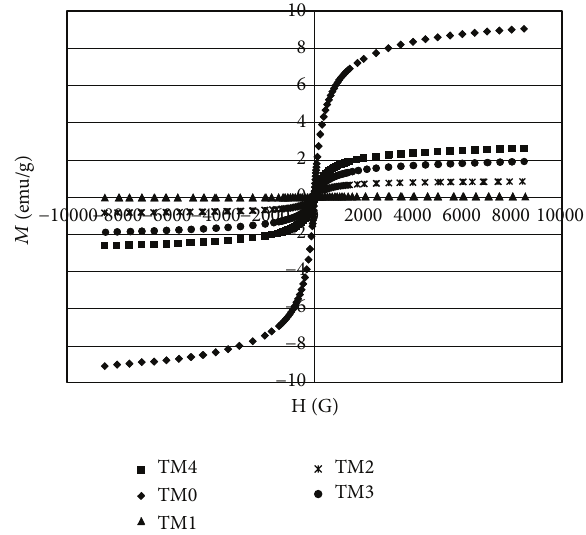
Figure 8: Magnetite properties of toner synthesize with various types of Fe 3 O 4